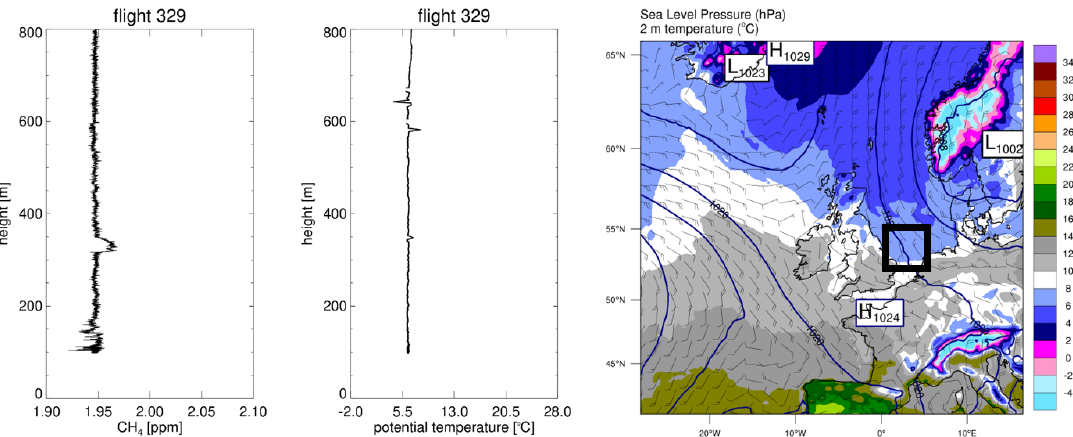
Figure 5. Example of CH 4 and potential-temperature profiles in a well-mixed boundary layer under neutral conditions. The potential temper- ature and CH 4 profiles stay relatively constant and CH 4 shows only an increase in the surface layer and when intercepting an enhancement at 300 to 350m height. The synoptic chart for 6 May 2019 12:00UT shows a cyclonic south-easterly airflow over the southern North Sea sector originating from the Benelux region. The black rectangle approximates the survey region over open